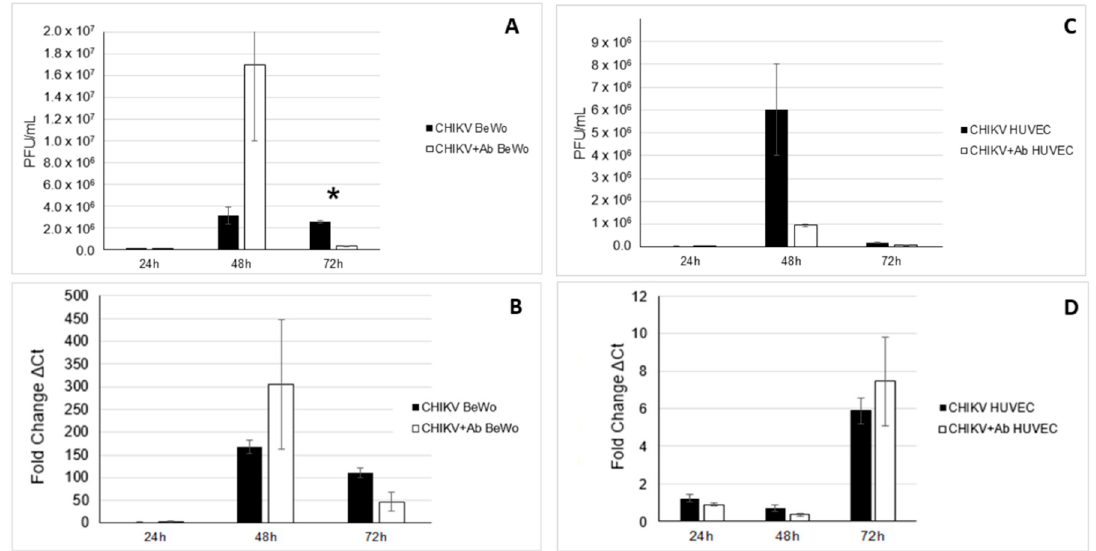
Figure 3. Viral titration as well as RT-PCR of BeWo and HUVEC cell lines. Viral titrations via plaque assay were performed for BeWo and HUVEC cells infected with CHIKV and CHIKV + VEEV antibodies. ( A ) Viral titrations showed that significantly less CHIKV was detected in BeWo cells at 72 h when VEEV antibodies were present ( p = 0.0162, n = 6). ( B ) Significant increases in viral genome copy were observed at all time points for BeWo cells for both CHIKV only ( p = 0.021–0.037) and CHIKV + VEEV antibody ( p = 0.009–0.021) treatments. However, there was no significant difference in Ct value at each time point for pairwise comparison for CHIKV only compared to CHIKV + VEEV antibodies. ( C ) Viral titrations displayed that there was no significant difference in CHIKV at any time point, with or without the presence of VEEV antibodies in HUVEC cells. There was significant increase in viral titers of CHIKV between 24 and 48 h ( p = 0.0372, n = 6), but a significant decrease in viral titers between 48 and 72 h ( p = 0.029, n = 6). ( D ) HUVEC cells exhibited significant increases in viral genome copies over all time points for CHIKV only ( p = 0.021–0.037, n = 6) and CHIKV + VEEV antibodies ( p = 0.009–0.021, n = 6). * denotes statistical significance between treatments.